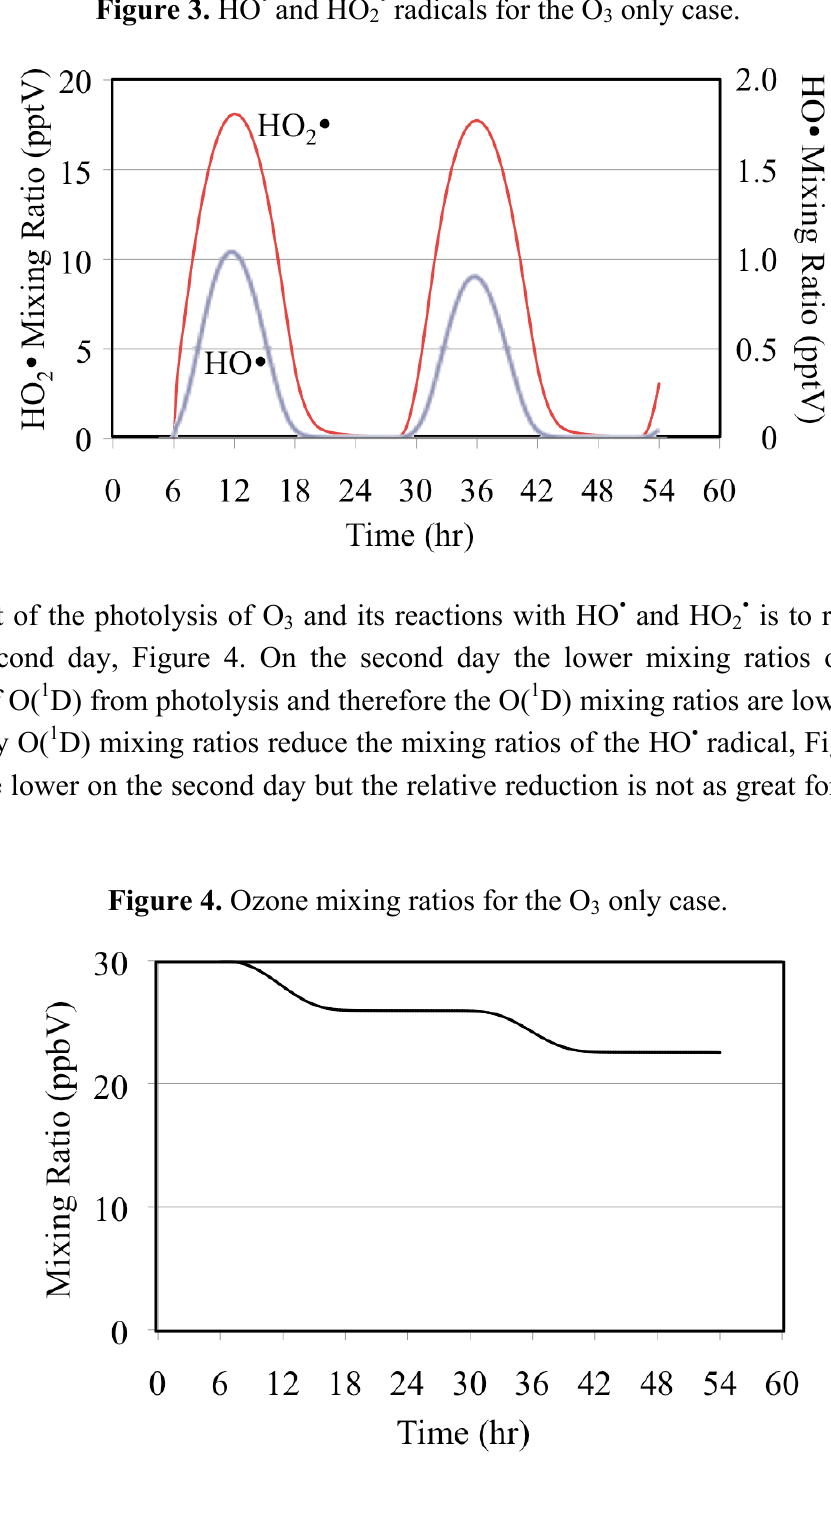
Figure 3. HO • and HO 2• radicals for the O